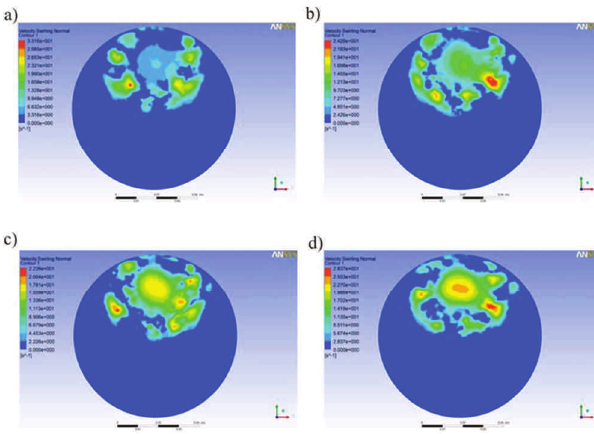
where: A – surface area of the swirling air flux; A – swirl surface area of the cross-section of the air flow (cylinder cross-section). By using a computer application for an analysis of the swirl area we obtained a relation among the swirl area, the Fig. 11. The distribution of swirl inside the cylinder for charge’s flow initial air flow velocity (w) and the angle of flexible ele- velocity w = 4 m/s; a) q = 6 deg, b) q = 12 deg, c) q = 18 deg, d) q = 24 ment twisting ( θ ). This relation was illustrated in Fig. 14. deg